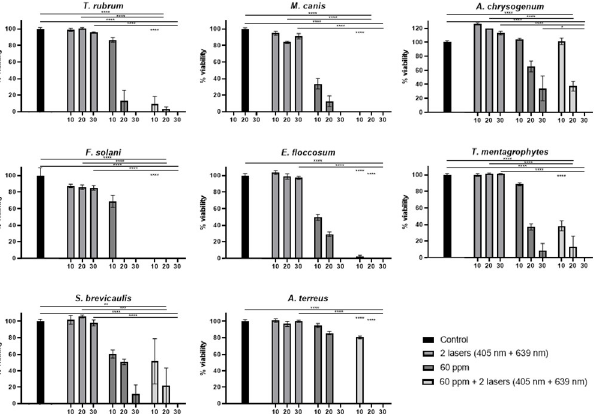
Fig 5. Percentage of viability for each of the eight fungal species with ozone treatment 60 ppm in combination with both laser treatments simultaneously at three different times (10 min, 20 min and 30 min). Statistical significant results of the combined ozone and laser treatments are shown in comparison with only ozone, only laser treatments or absolute control at each time point, and indicated with asterisk. Asterisks without a comparison line indicate the same statistical significant results between all conditions at the same